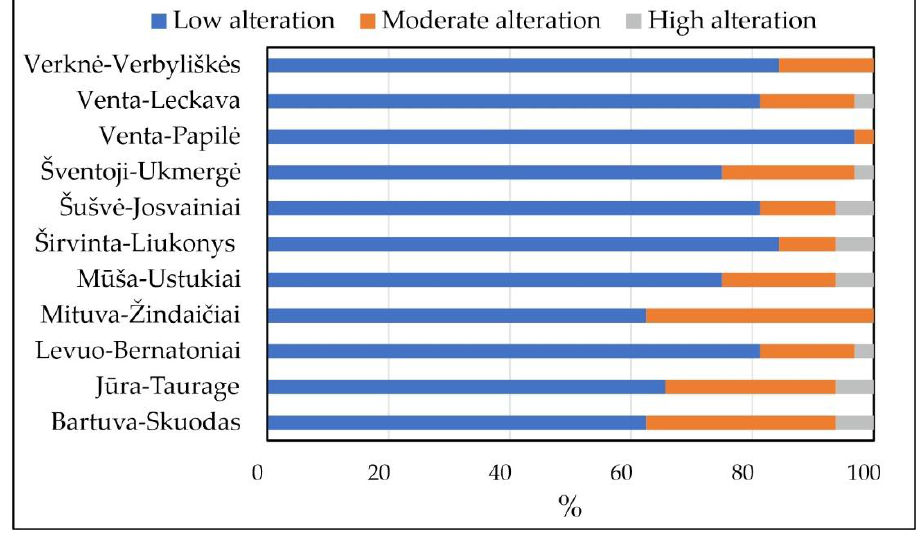
Figure 11. The percentage of hydrologic indicators in each RVA category.